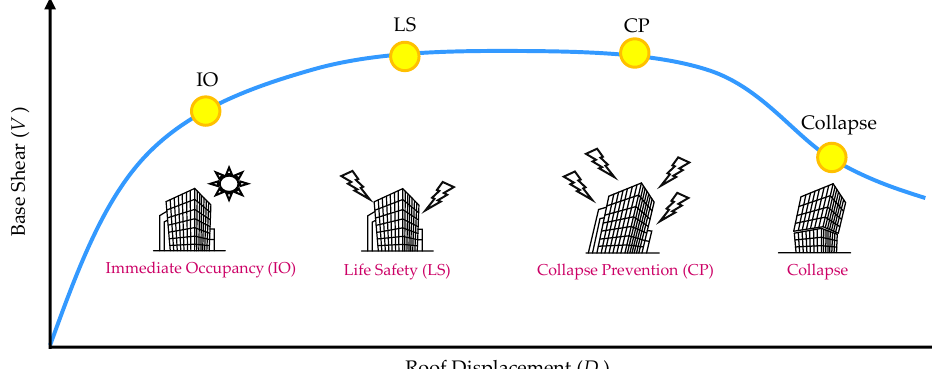
Figure 4. Example of performance-based seismic design (PBSD) performance/safety levels based on pushover